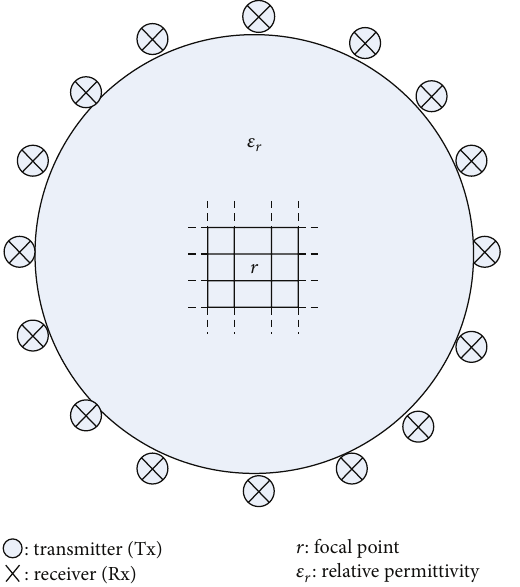
Figure 6: Sensing geometry of multistatic aperture radar with 16